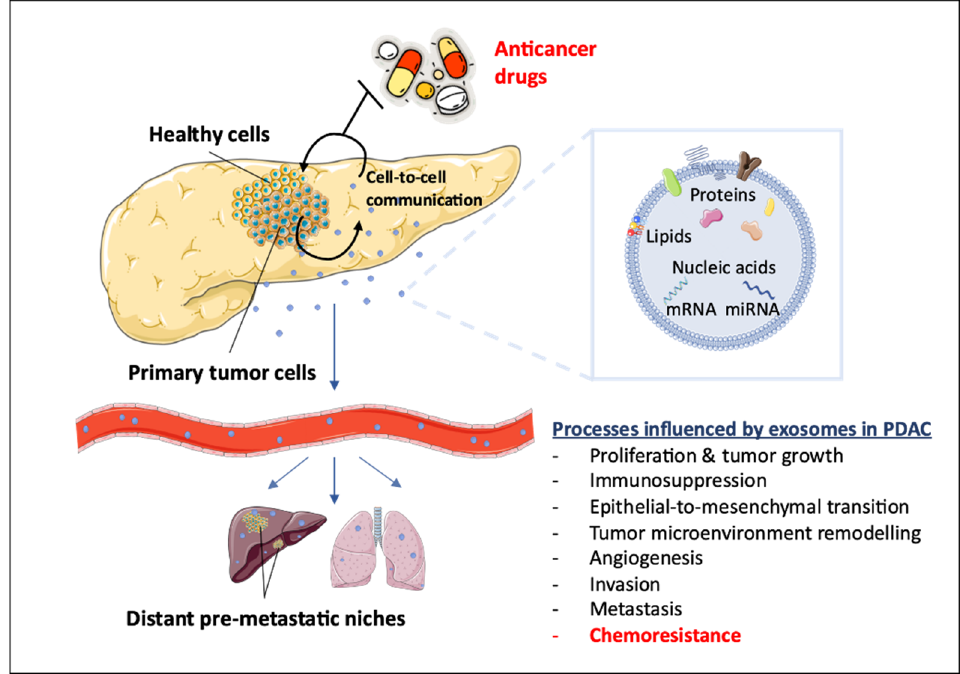
Figure 1. Schematic representation of exosome-related tumor processes. Exosomes mediate several important processes in PDAC pathogenesis, such as EMT and metastasis, and play a key role in pancreatic carcinoma chemoresistance.